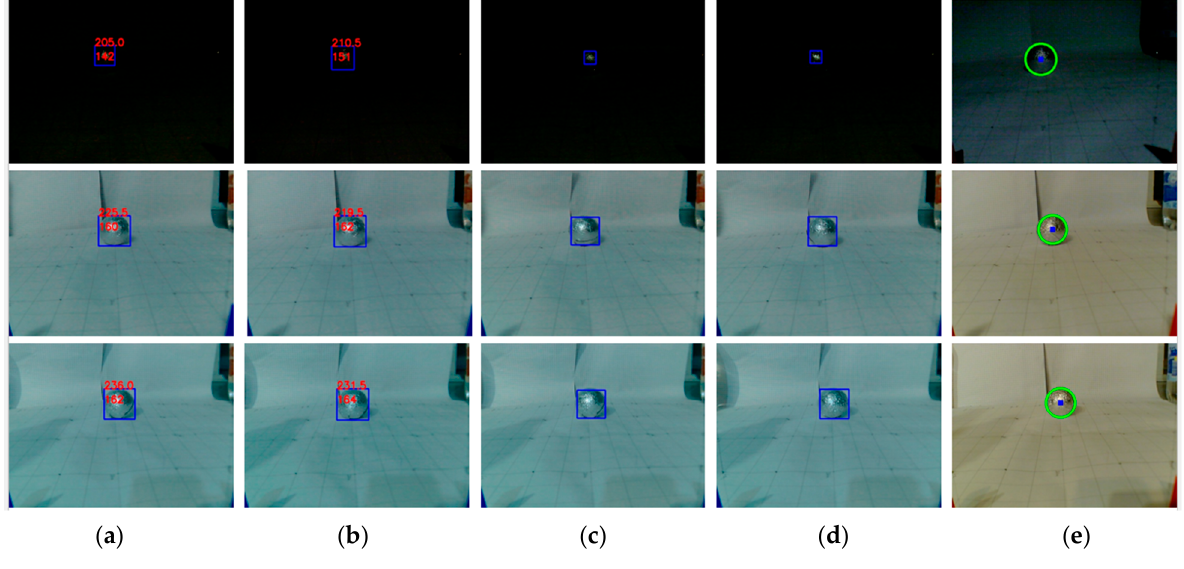
Figure 12. Comparison of predictions of the robot. From left to right: ( a ) MO- BILENET_V3_LARGE_320, ( b ) RESNET50, ( c ) EFFICIENTNET-B0, ( d ) MOBILENET_V2, ( e ) Hough 50-40-50 transform. Differences in white balance in the last column are the result of the OpenCV library. Blue bounding boxws represent predicted objects using deep learning methods, and green circle represent predicted objects using Hough transform.